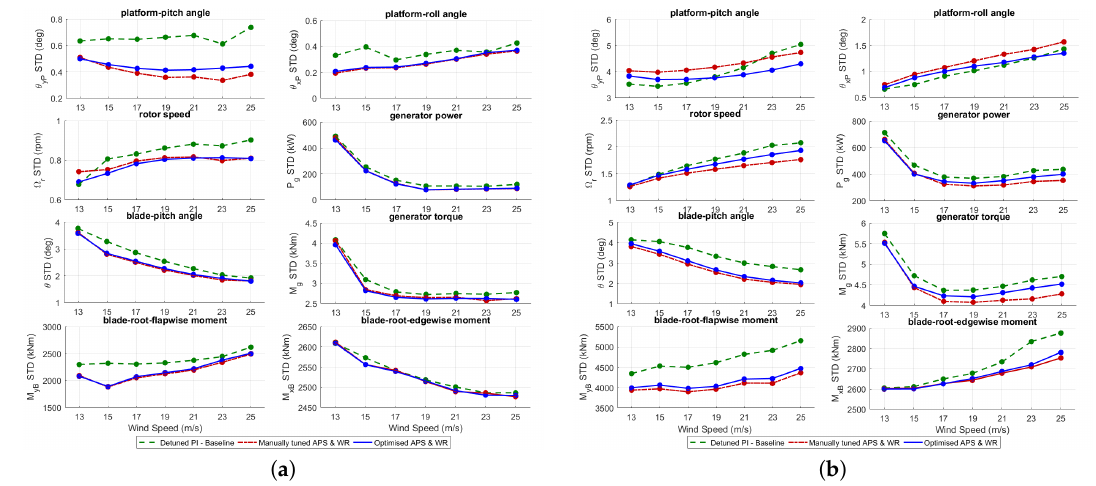
Figure 9. Time-domain simulation Standard Deviations results. ( a ) H s = 0 m. ( b ) H s = 6